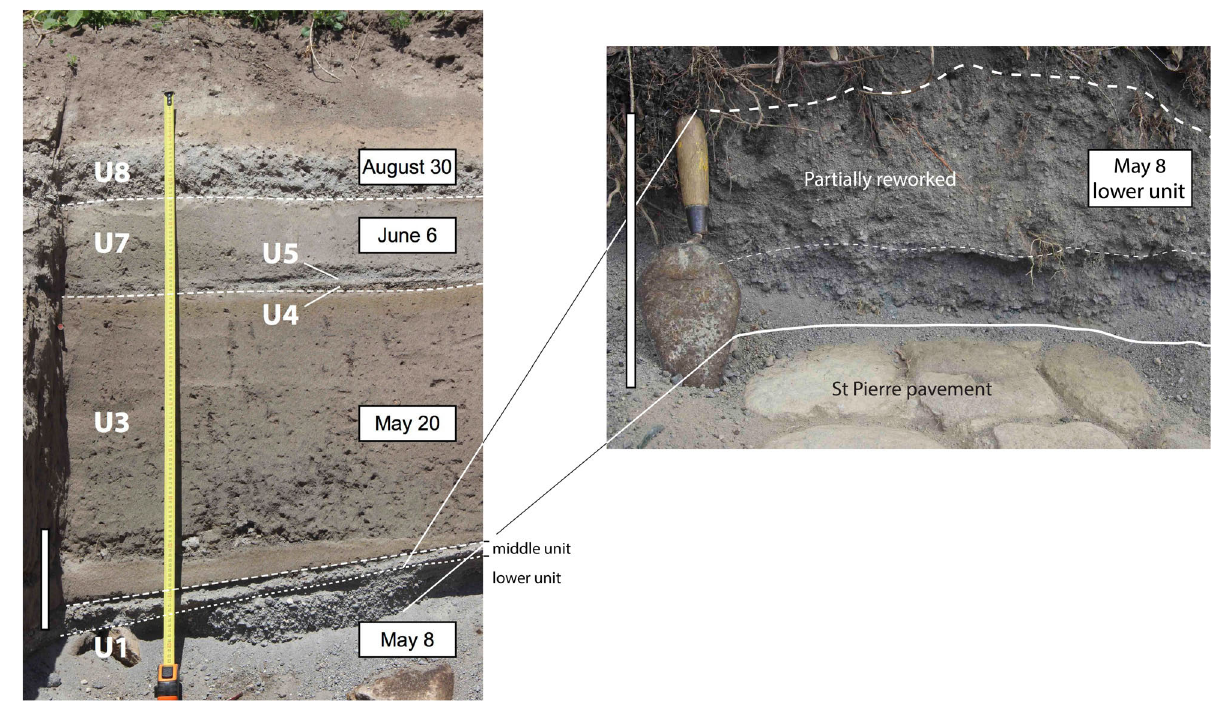
Frontiers in Earth Science |